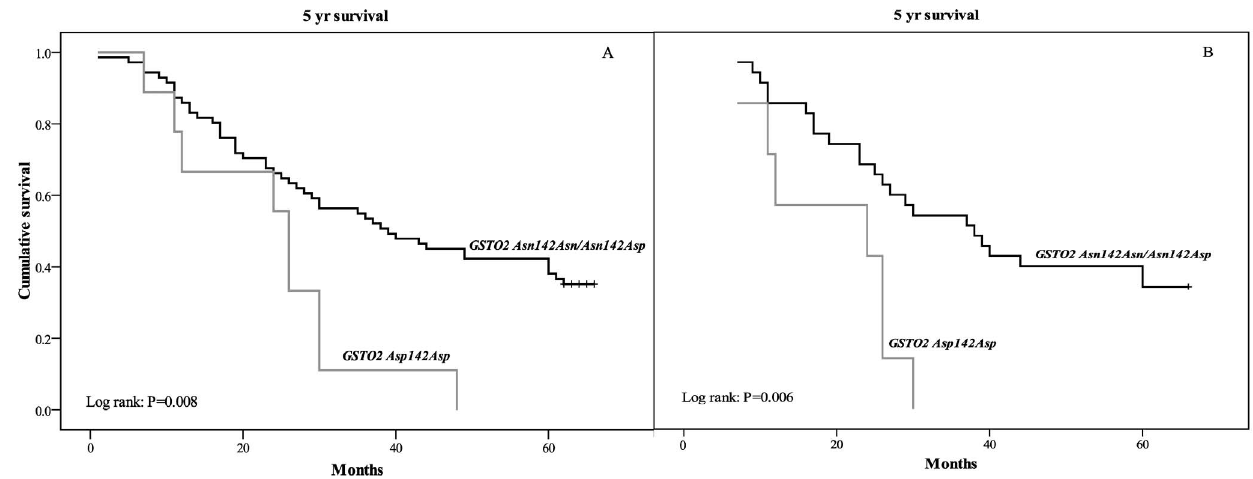
Figure 4. Survival analysis Kaplan–Meier curves according to GSTO2 polymorphism for overall mortality (A), as well as mortality of TCC patients on chemotherapy (B).